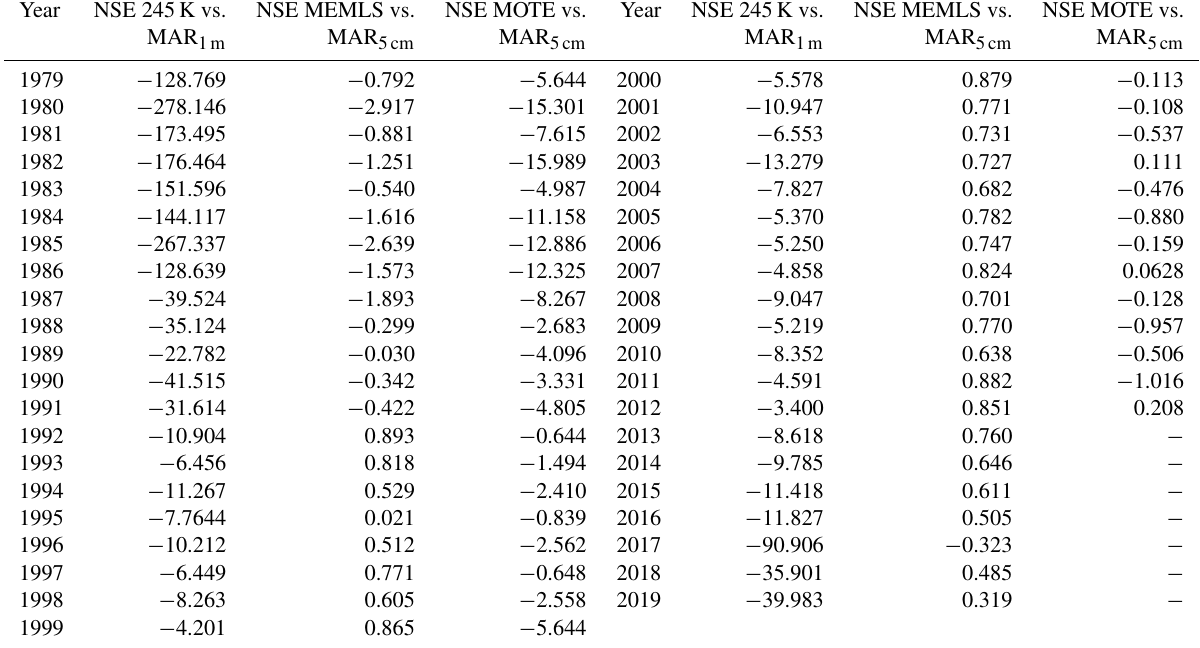
Table 6. Nash–Sutcliffe efficiency (NSE) coefficients computed for the comparison of the retrieved melt extent using the 245K and MEMLS algorithms applied to the enhanced-resolution PMW T b and MAR liquid water content outputs averaged in the first 1m and the first 5cm of the snowpack. The Nash–Sutcliffe efficiency coefficients for the comparison of the coarse-resolution dataset (Mote, 2014) are computed considering MAR 5cm